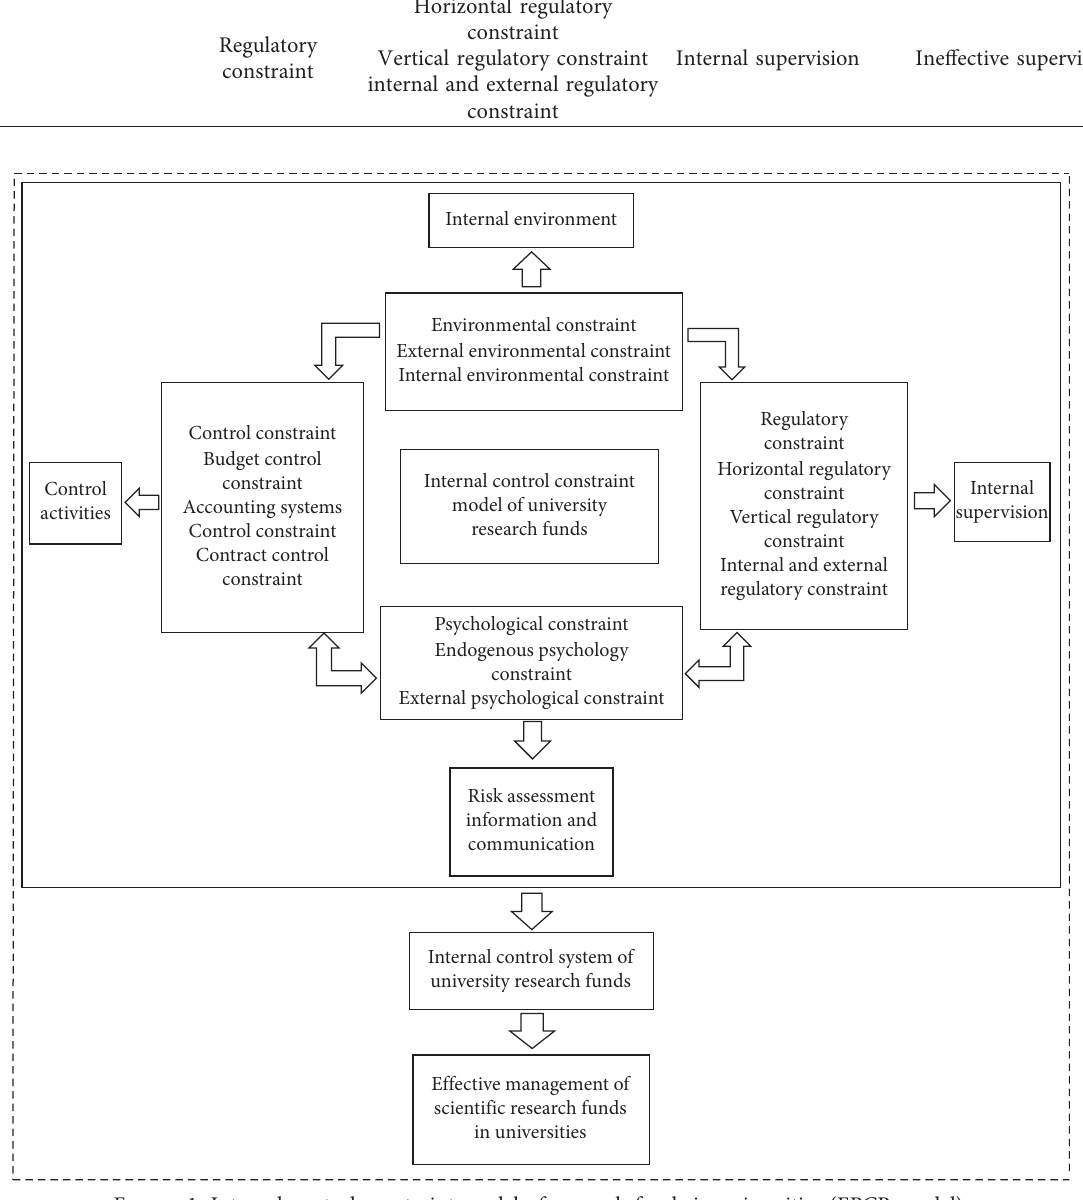
Figure 1: Internal control constraint model of research funds in universities (EPCR